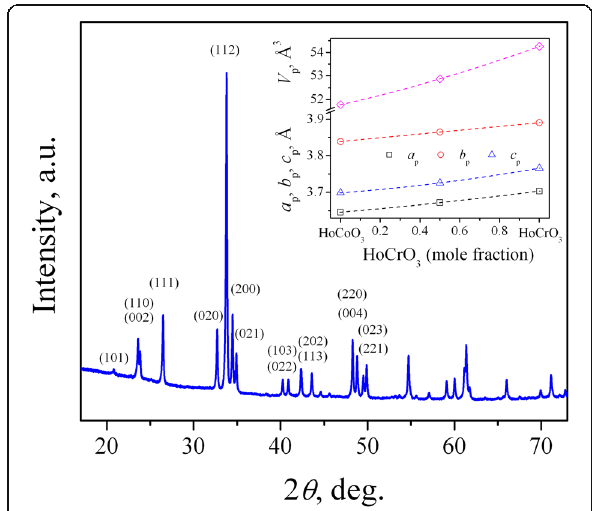
Fig. 1 XRD pattern of HoCo 0.5 Cr 0.5 O 3 at room temperature (Cu K α 1 radiation, Guinier camera). Insets show concentration dependence of the unit cell parameters in the HoCoO 3 – HCrO 3 system. The orthorhombic lattice parameters are normalized to the perovskite cell as follows: a p = a o / √ 2, b √ 2, c p = b o / p = c o /2, V p = V o